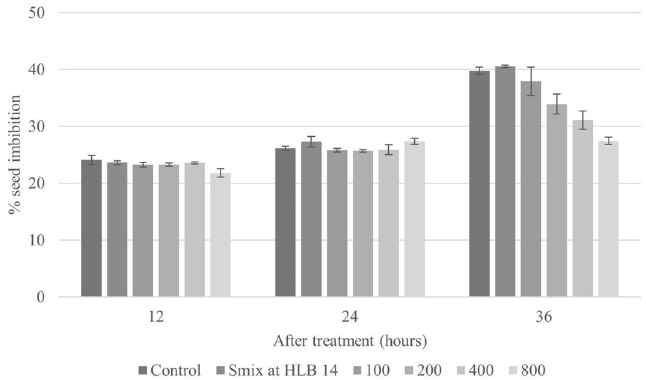
Figure 7. The effect of the optimized CEO nanoemulsion on imbibition of E. crus-galli seeds at 12, 24, and 36 h. Error bars represent standard deviation of the mean.